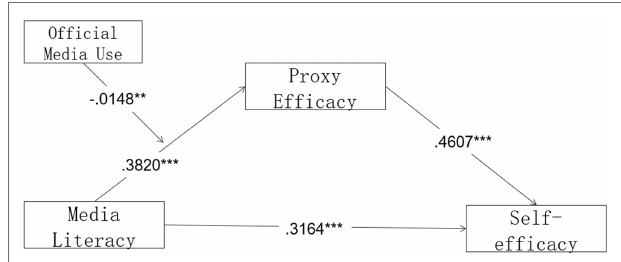
FIGURE 3 | Model with